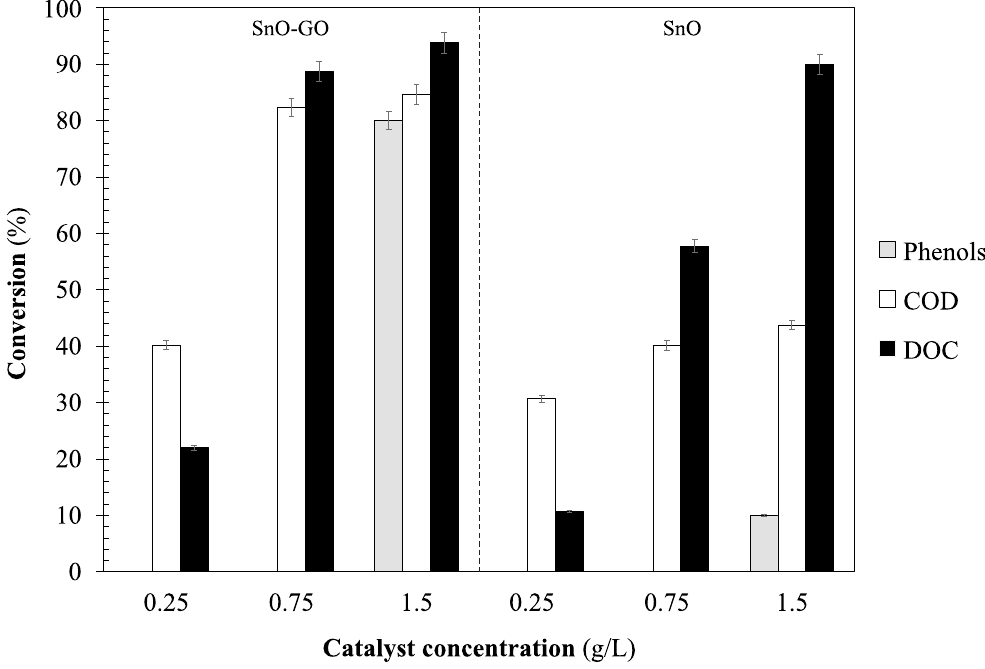
Figure 7. Removal efficiencies of chemical oxygen demand, phenols and dissolved organic matter Figure 7. Removal e ffi ciencies of chemical oxygen demand, phenols and dissolved organic matter after after the photocatalytic process with SnO-GO and SnO. the photocatalytic process with SnO-GO and